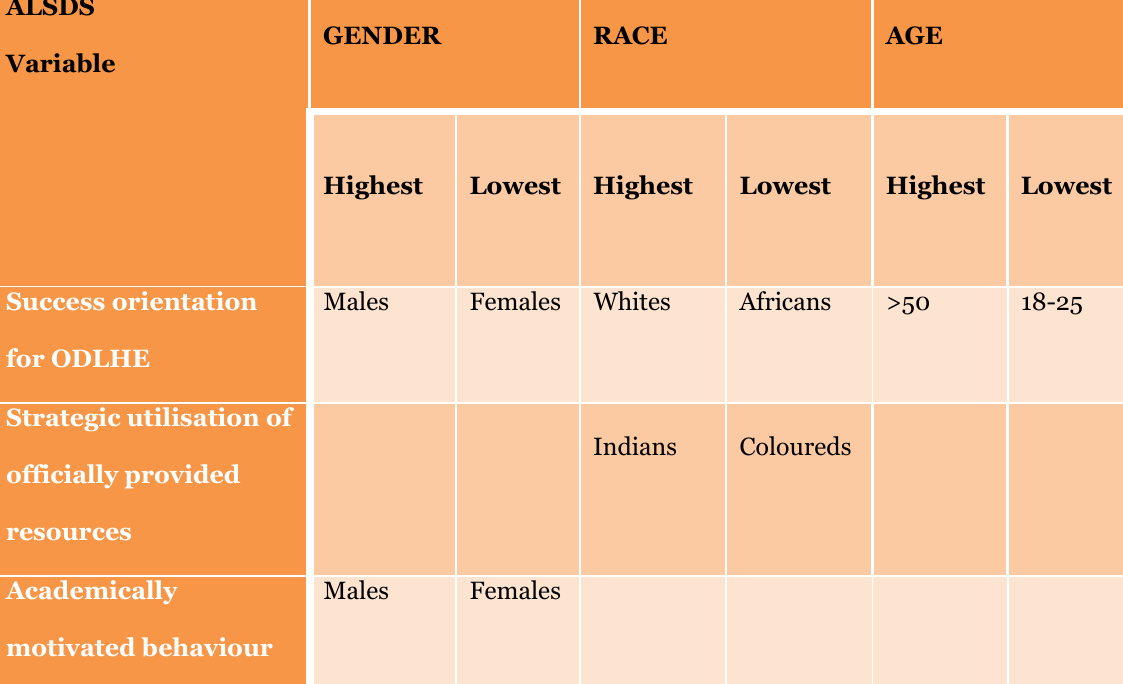
Summary of the Significant Differences between Gender, Race and Age in terms of the ALSDS ALSDS